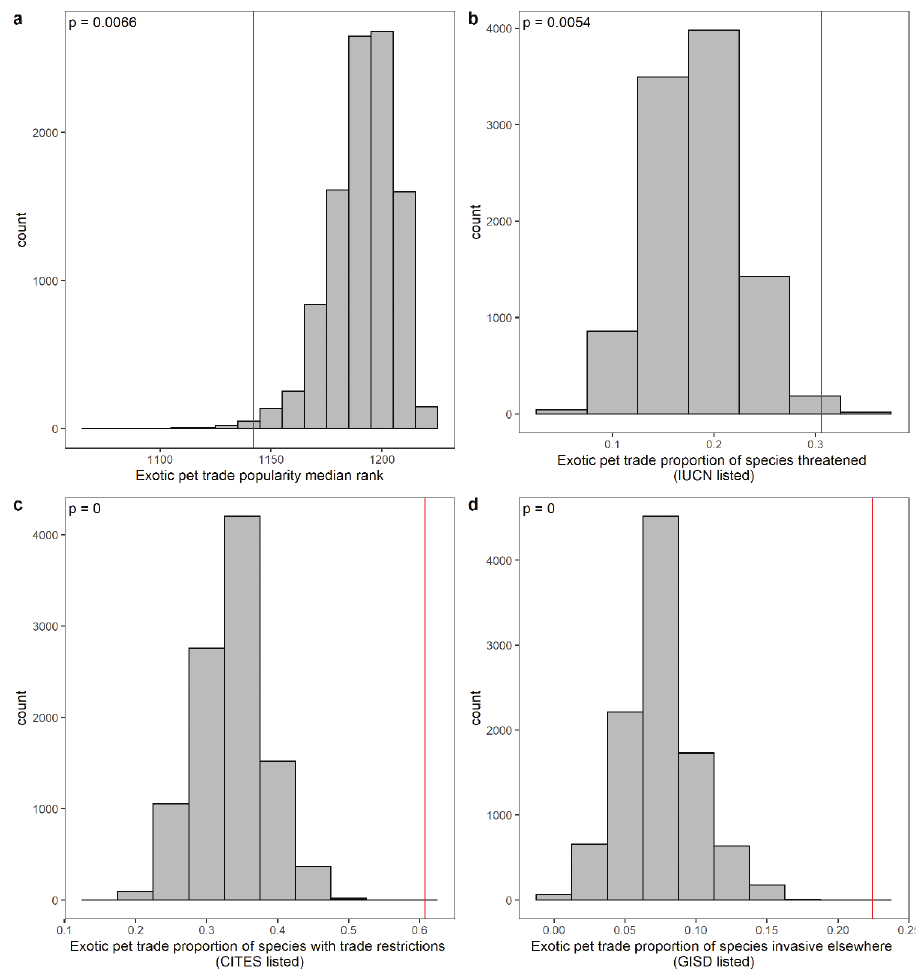
Figure 4. Empirical hypothesis tests comparing: ( a ) enquired species popularity; ( b ) proportion of threatened species; ( c ) proportion of international trade-restricted species; and ( d ) proportion of invasive species, to the overall exotic pet trade. Each histogram represents 10,000 iterations of random sampling from the U.S. Fish and Wildlife imports dataset from 1999–2016 (representative of the Western exotic pet trade), stratified by taxonomic class. Red lines correspond to the ‘observed’ median rank or proportion from the enquired species. P-values are calculated as the proportion of sampling iterations that fall to the left or right of the observed rank or proportion. Non-vertebrate taxa were not included in these